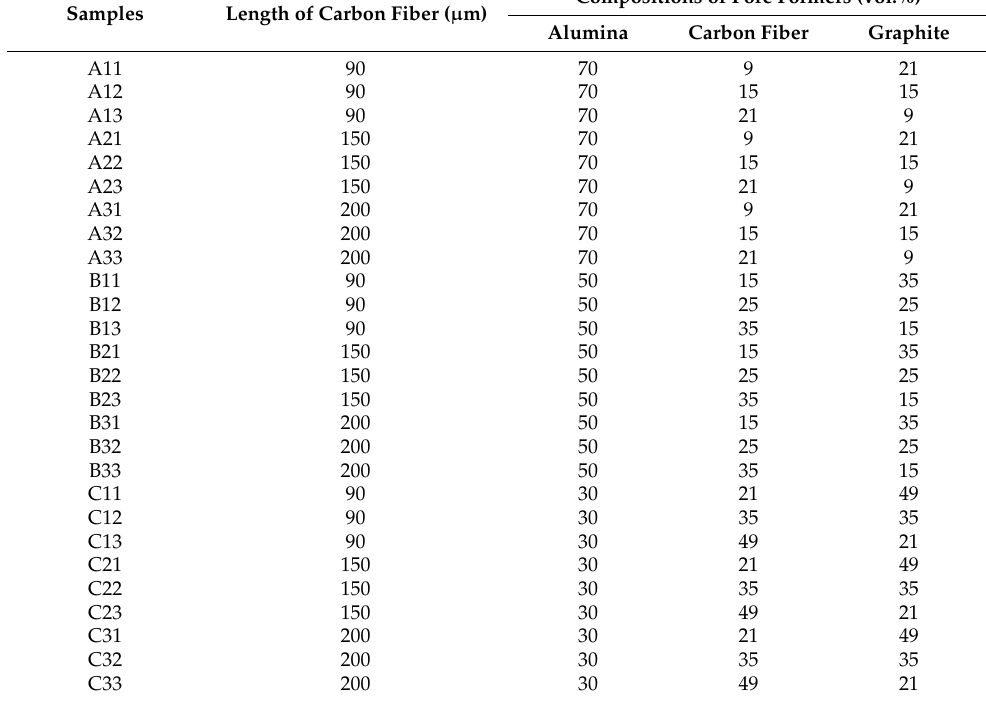
Table 2. The ratios of raw